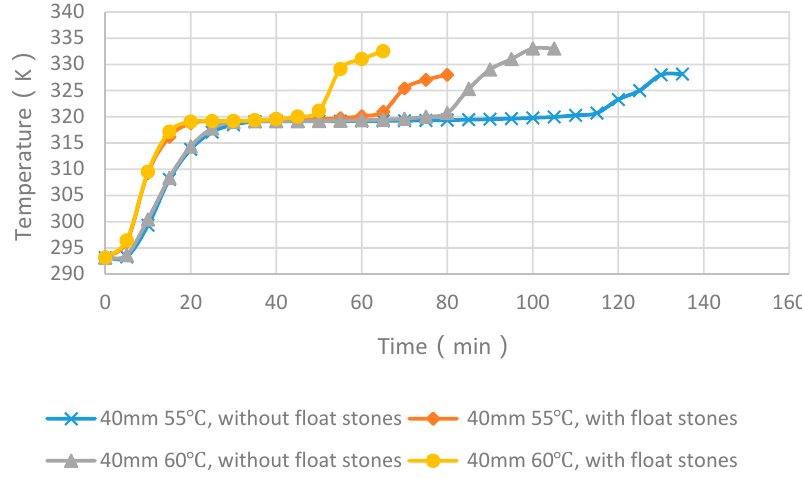
Figure 13. Comparison of melting time between PCM cylinder modules with and without float stones when the diameter is 40 mm.